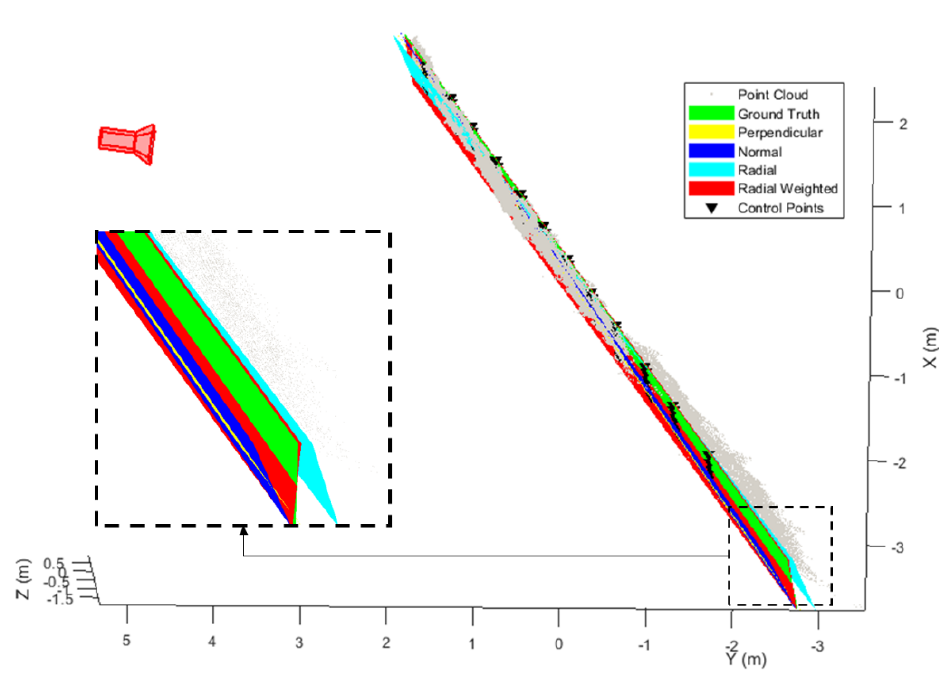
Figure 14. The errors of the control points after plane fitting calibration.